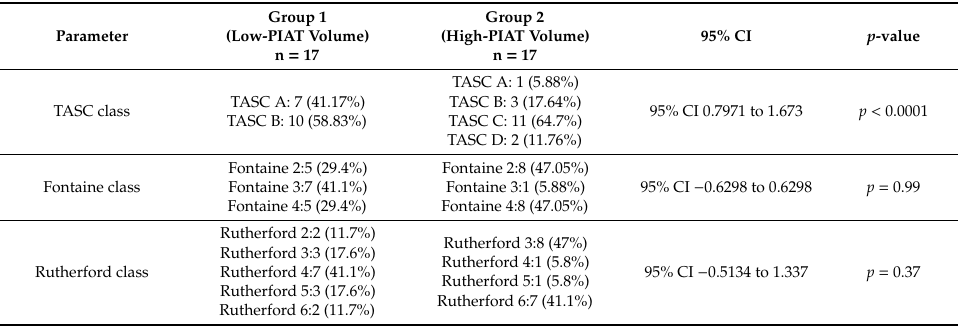
Table 2. Severity and complexity of peripheral artery disease in the study groups. Severity of peripheral arterial disease is expressed by Fontaine class and Rutherford stage, while complexity is reflected by the Trans-Atlantic Inter-Society Consensus (TASC)